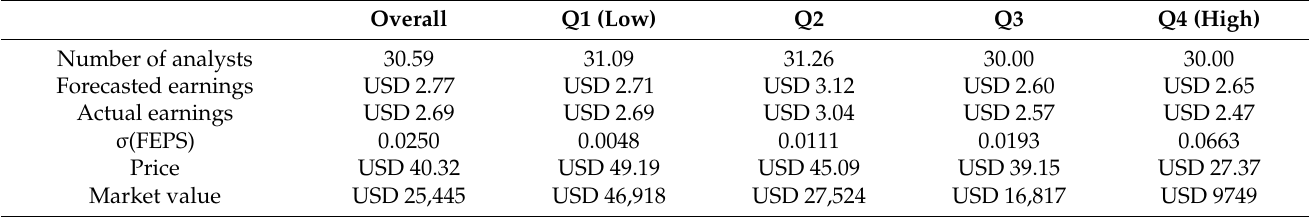
Table 1. Summary statistics: The table reports summary information for our sample which includes data from January 1997 through December 2018. In addition to full sample information, Panel A provides sample statistics for quartiles based on the standard deviation of analysts’ forecasts scaled by price ( σ (FEPS)), and Panel B reports information for quartiles based on market value (MV). First, the table reports the number of analysts following sample firms as reported in the IBES database. Next, the table reports on forecasted and actual earnings, σ (FEPS), stock price, and market value (in millions of dollars). Panel A: Means for the Full Sample as Well as Quartiles Determined by the Standard Deviation of Analysts’ Earnings Forecasts Scaled by Price ( σ